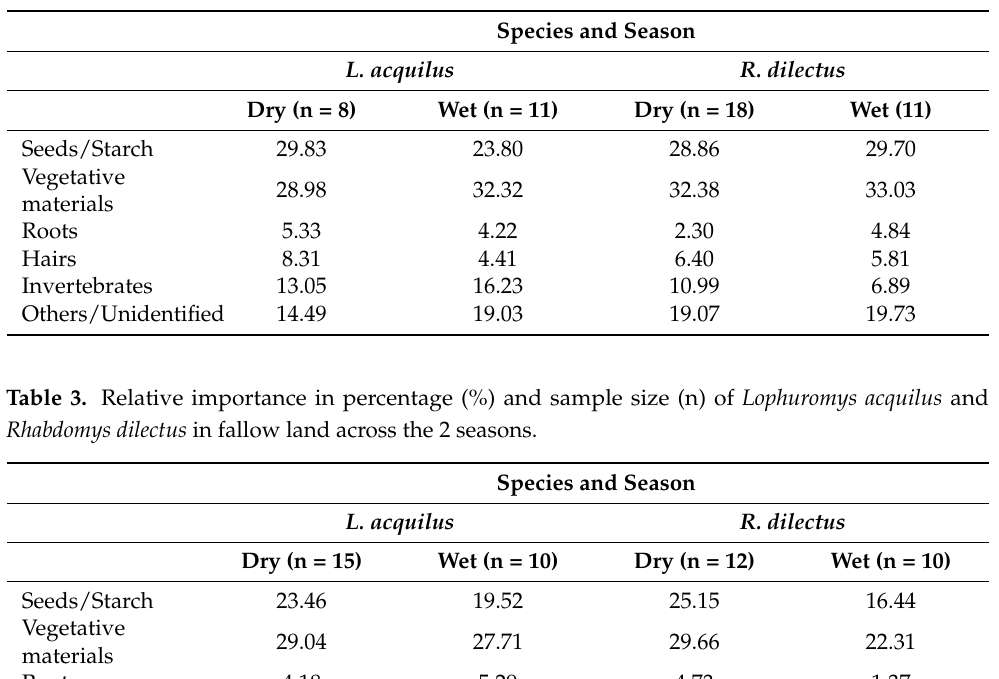
Table 2. Relative importance in percentage (%) and sample size (n) of L. acquilus and R. dilectus in agricultural fields across the 2 seasons.